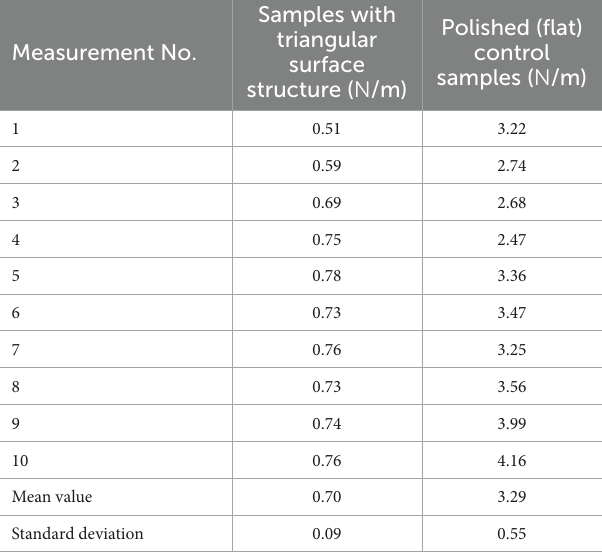
This equation fulfills the Laplace equation as well as three of the four boundary conditions exactly. Only at the inclined upper part, where U = V, there is a deviation, which depends on the ratio a / h . If this ratio is small, in other words, if the distance h is larger than the amplitude of the surface structure, this approximation is pretty good as will be seen. A result for the above equation for V = 1 is shown in Figures 10D,E. The distance h was assumed to be 10 times the height a and the x-distance λ was assumed to be a /2. For this setting the boundary conditions are well fulfilled as can be seen from the 3D mesh in Figure 10D. The potential is rather homogeneous, as is the electric field. The larger the distance h compared to the amplitude a , the better the homogeneity of the field. Thus, for